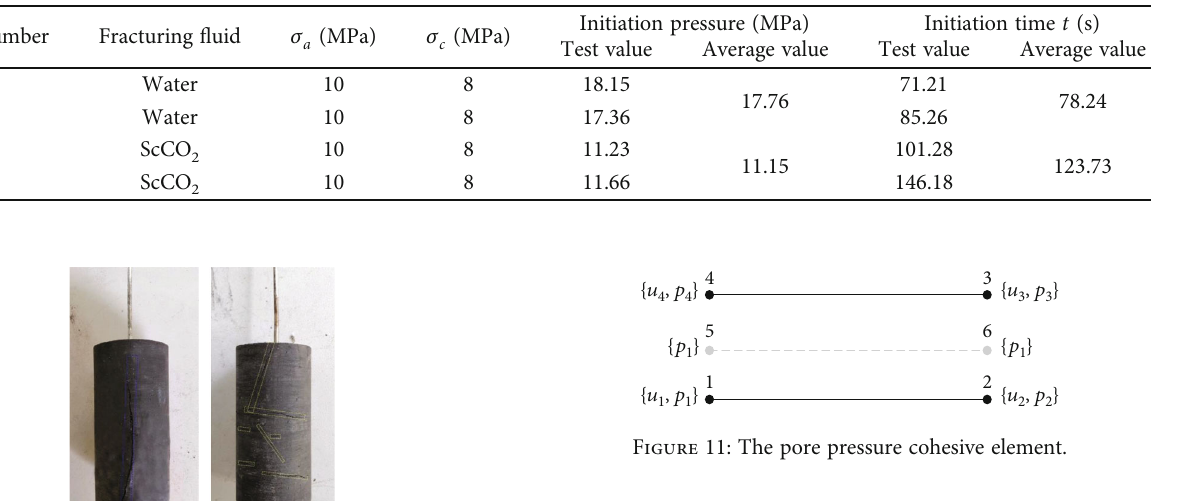
fracturing test results of the coal specimens. 2